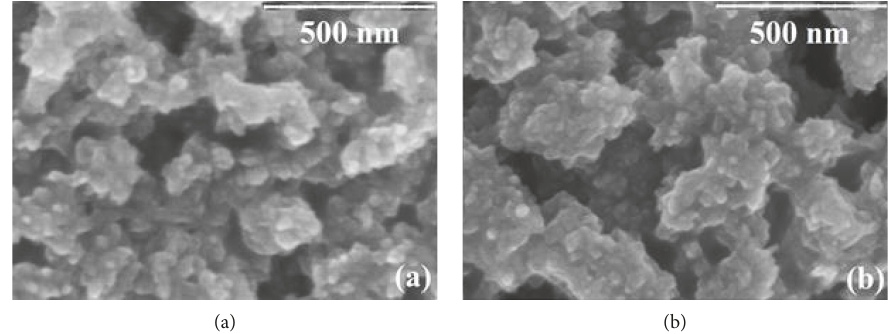
Figure 5: SEM images of the surface of TiO sintering. The nanoparticles deposited, using spin coating method, (a) 50 wt% SA-TiO